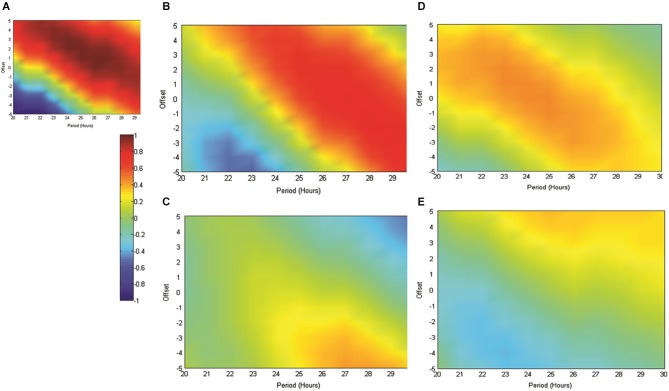
(A) The matrix produced by correlating an array of sinusoids with period x and offset y hours against the artificially generated sine wave used as a reference throughout this study (as in 4A). As indicated in the scale, “hotter” colors represent increasingly positive correlations, while “cooler” colors represent increasingly negative correlations. (B) illustrates the matrix produced when the mean normalized normalized RAT frequency is correlated against sinusoids of varying period and offset and when individual datasets are referenced to the normal feeding time at 6 pm. In (C), data are referenced to the start of the recording, which since it varied across the day, removes any association with the feeding time. (D,E) illustrate the matrices produced when mean RAT frequency is correlated against sines of varying period and offset. For these datasets, food was made available on hour 2 of the recording and the data are shown either (D) referenced to recording start, or shifted so as to be referenced to the time of day, and by implication normal feeding time at 6 pm (E).